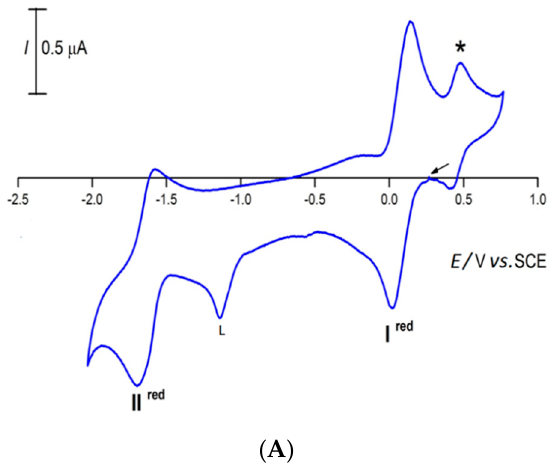
Table 1. Cyclic voltammetric data a for the Fe(III) complexes 1–4.